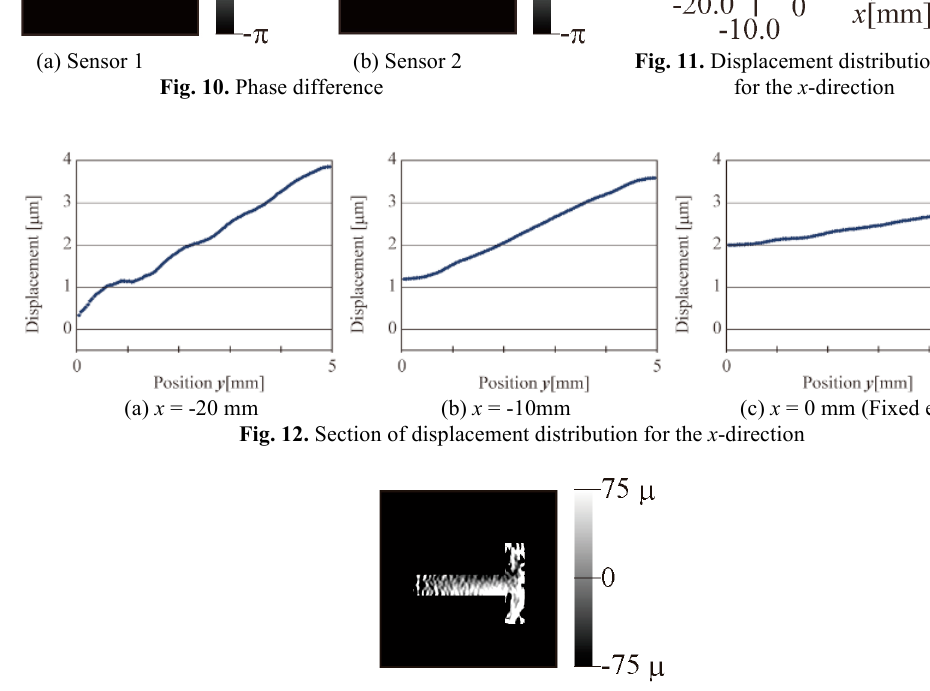
Fig. 13. Strain distribution for the x